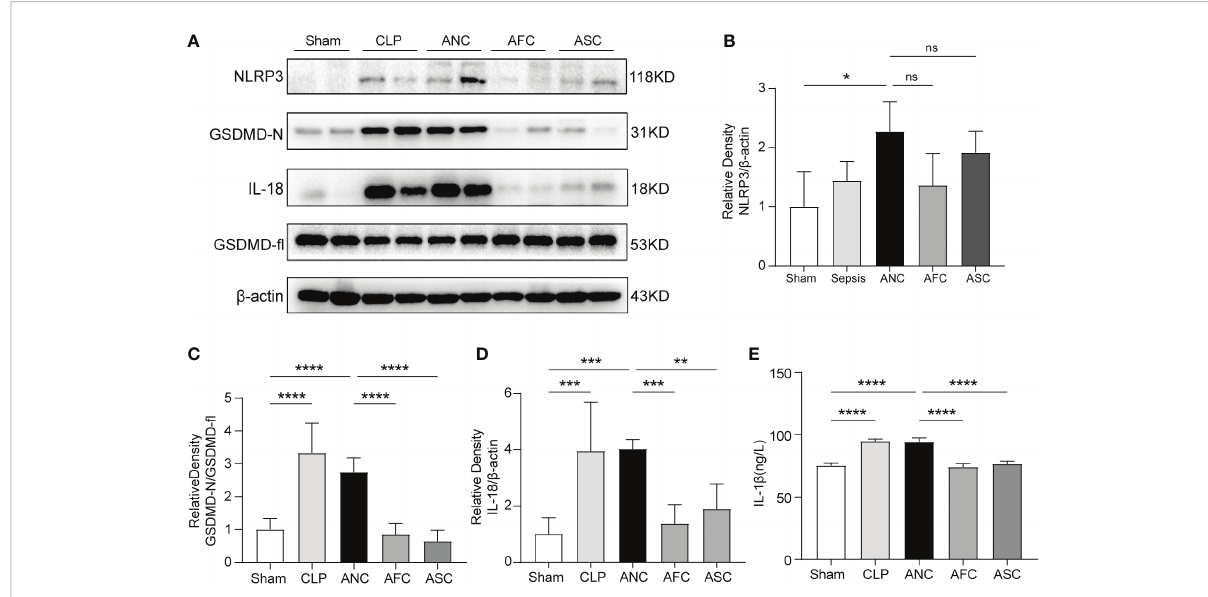
FIGURE 6 Colonic protein expression of pyroptosis-associated genes after sepsis in mice: the role of Fecal microbiota transplantation (FMT) and short- chain fatty acids (SCFAs). (A) Western blotting for the detection of NLRP3, IL-18, GSDMD- fl , and GSDMD-N. (B – D) The quantitative examination of the ratio of NLRP3/ b -actin, GSDMD-N/GSDMD- fl , and IL-18/ b -actin expression was performed, with the Sham group serving as the reference value. (E) The serum level of IL-1 b was measured using ELISA. n = 6 per group. Data are expressed as the mean ± SD. *P < 0.05; **P < 0.01; ***P < 0.001; ****P < 0.0001; ns: not signi fi